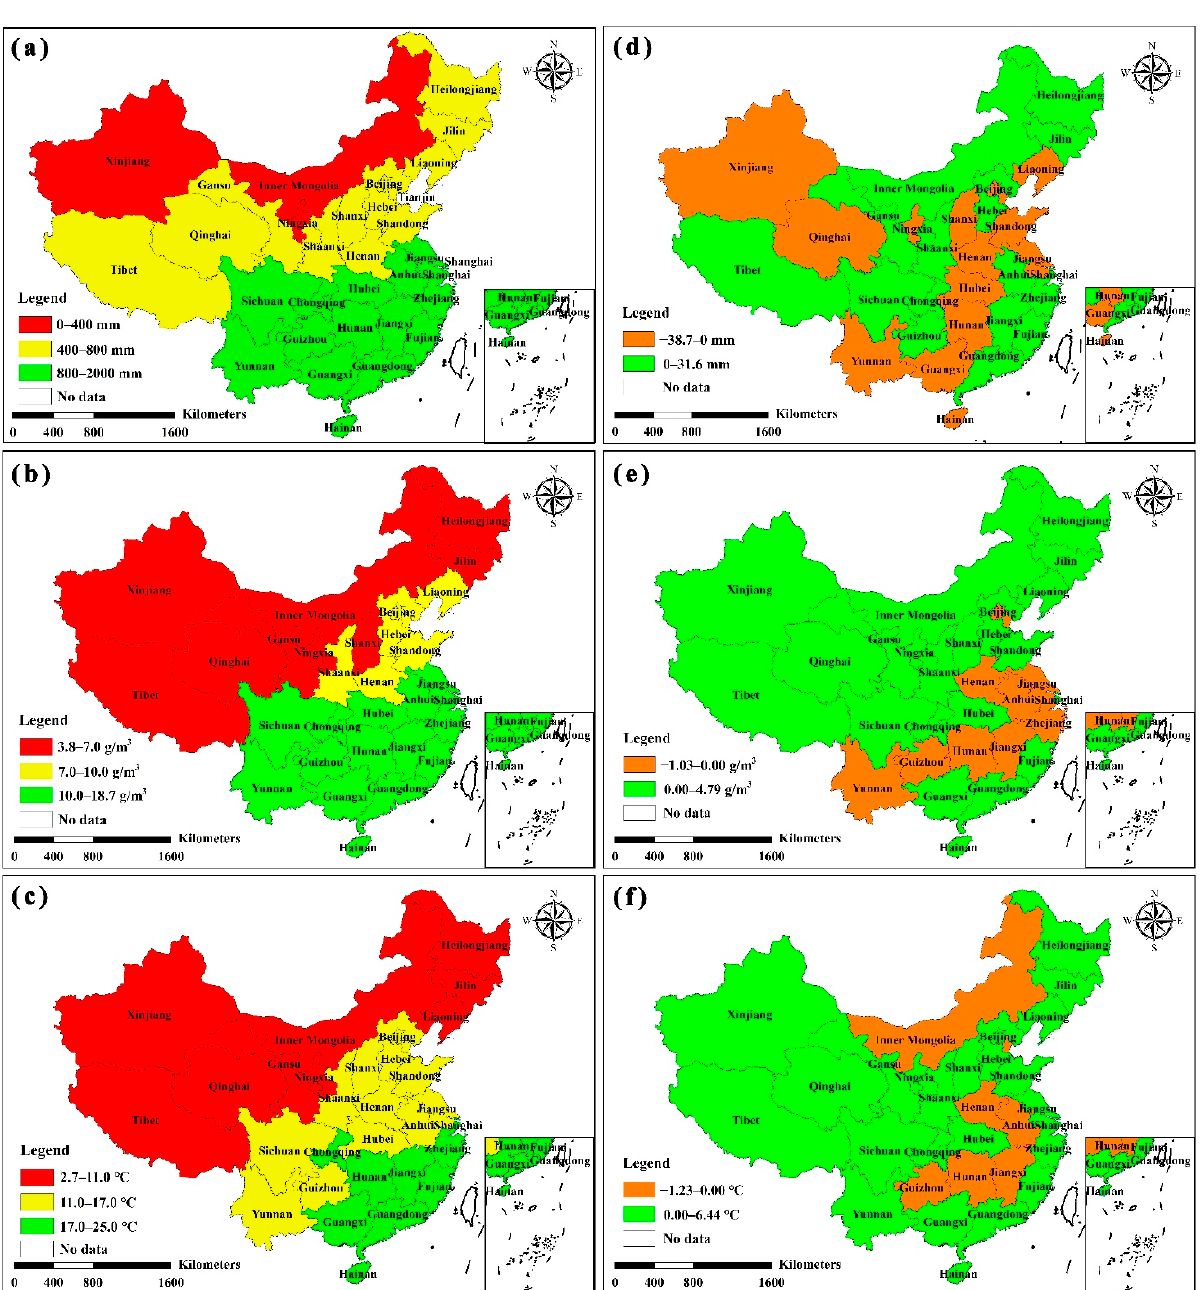
Figure 5. Spatial distribution of urban ( a ) precipitation, ( b ) absolute humidity, and ( c ) temperature (2010–2019). Comparisons of annual average ( d ) precipitation, ( e ) absolute humidity, and ( f ) temperature between urban and suburban areas (2010–2019).